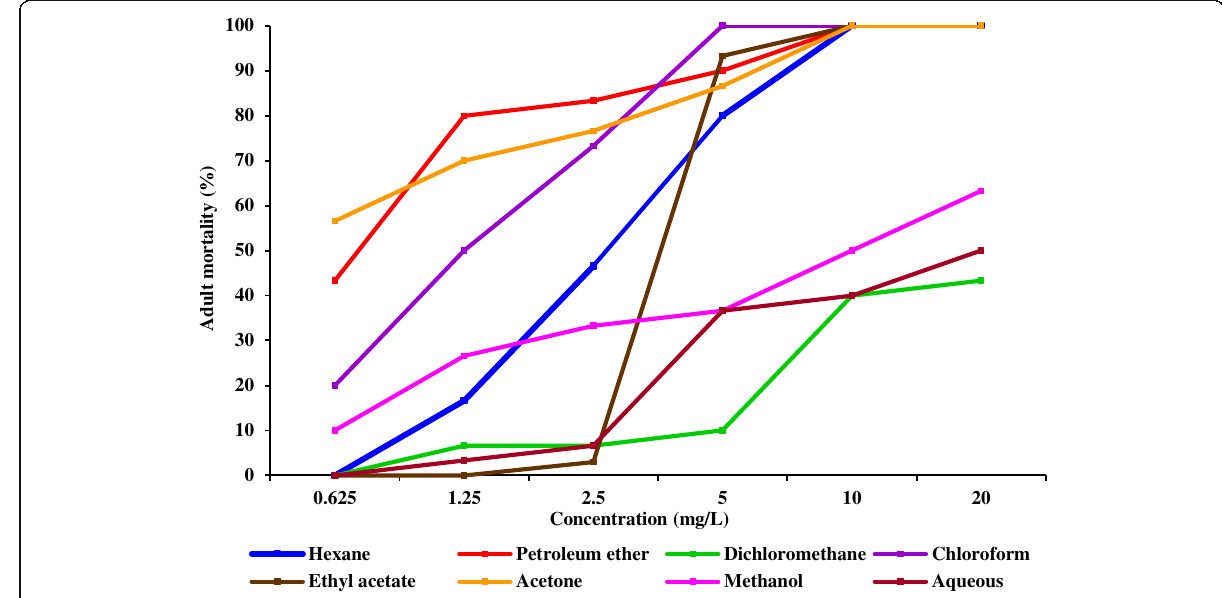
Fig. 1 Percent adult mortality of Sitophilus oryzae on exposure to Nicotiana tabacum leaf extracts at 24